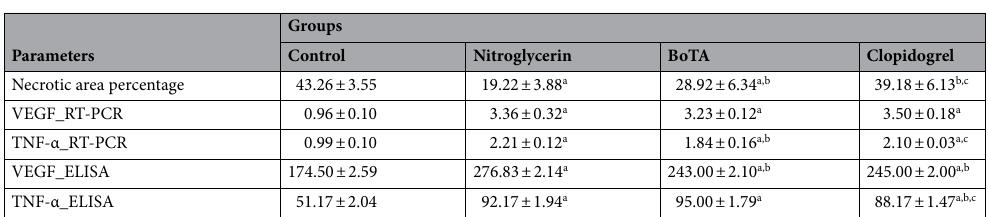
Table 2. Different parameters of induced flap venous congestion subgroups. Values are mean ± SD. a P < 0.05 versus control group, b P < 0.05 versus nitroglycerin group and c P < 0.05 versus BoTA group. Statistical analysis was performed by one way ANOVA followed by Tukey’s post-hoc test. BoTA botulinum toxin-A, TNF-α tumour necrosis factor-α, VEGF vascular endothelial growth factor.